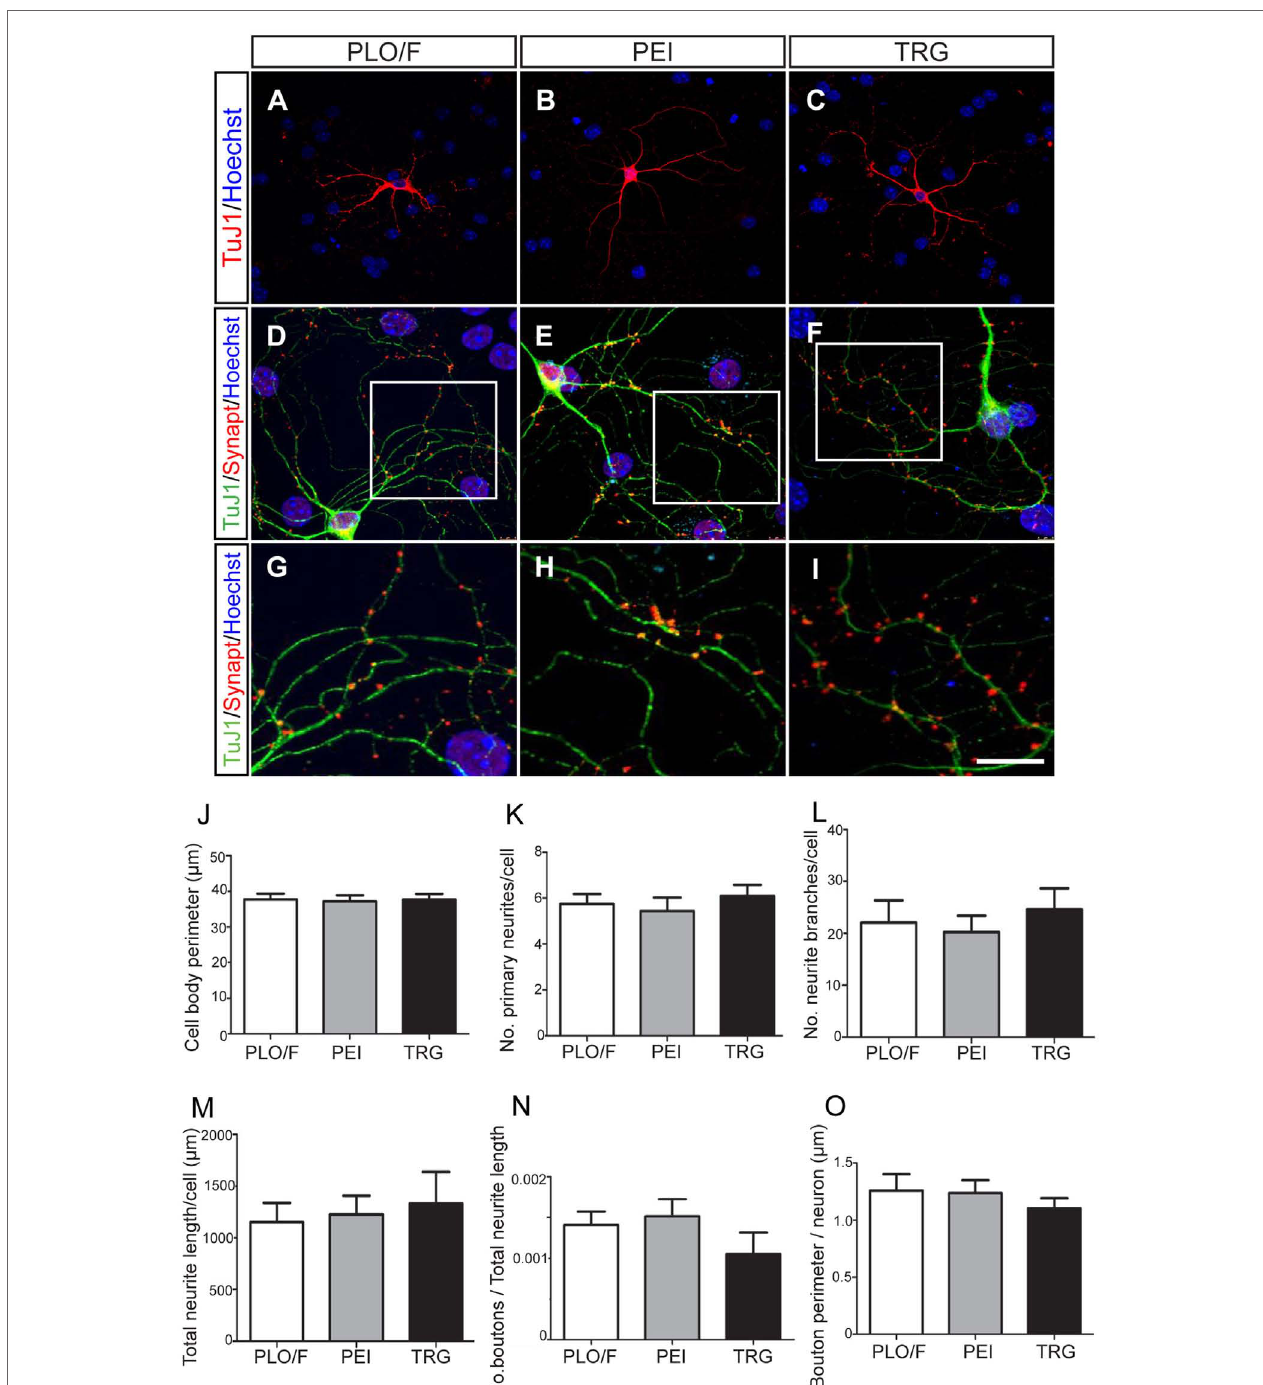
FigUre 5 | Trg is a permissive substrate for the morphological and synaptic maturation of neurons obtained from aOBscs . The aOBSC neurospheres were dissociated and seeded in a serum-containing medium for 15–18 DIV. Neuronal maturation was assessed by a morphological analysis in TuJ1 + neurons (a–c) . Four different parameters were analyzed in TuJ1 + cells and no significant differences were found (J–M) . To analyze the synaptic maturation, the culture was fed 20 ng/ml of BDNF during 18 DIV . Neurons and presynaptic boutons were detected using antibodies against β -III tubulin (TuJ1) and Synaptophysin (Synapt) (D–F) . An area of presynaptic boutons is shown at a higher magnification in the bottom panels (g–i) , each corresponding to the indicated square area in the photos above. No significant differences were found in the measured parameters for synaptic maturation of cells grown on PLO/F, PEI, or TRG (n,O) . The bars represent the mean ± SEM ( n = 20–31 TuJ1 + neurons; n = 15 TuJ1 + /Synaptophysin + neurons). Statistical analyses were performed using one-way ANOVA and Tukey’s test. Scale bar [shown in (i) ] = 50.6 μ m (a–c) , 23.4 μ m (D,e) , 10.1 μ m (g–i) .